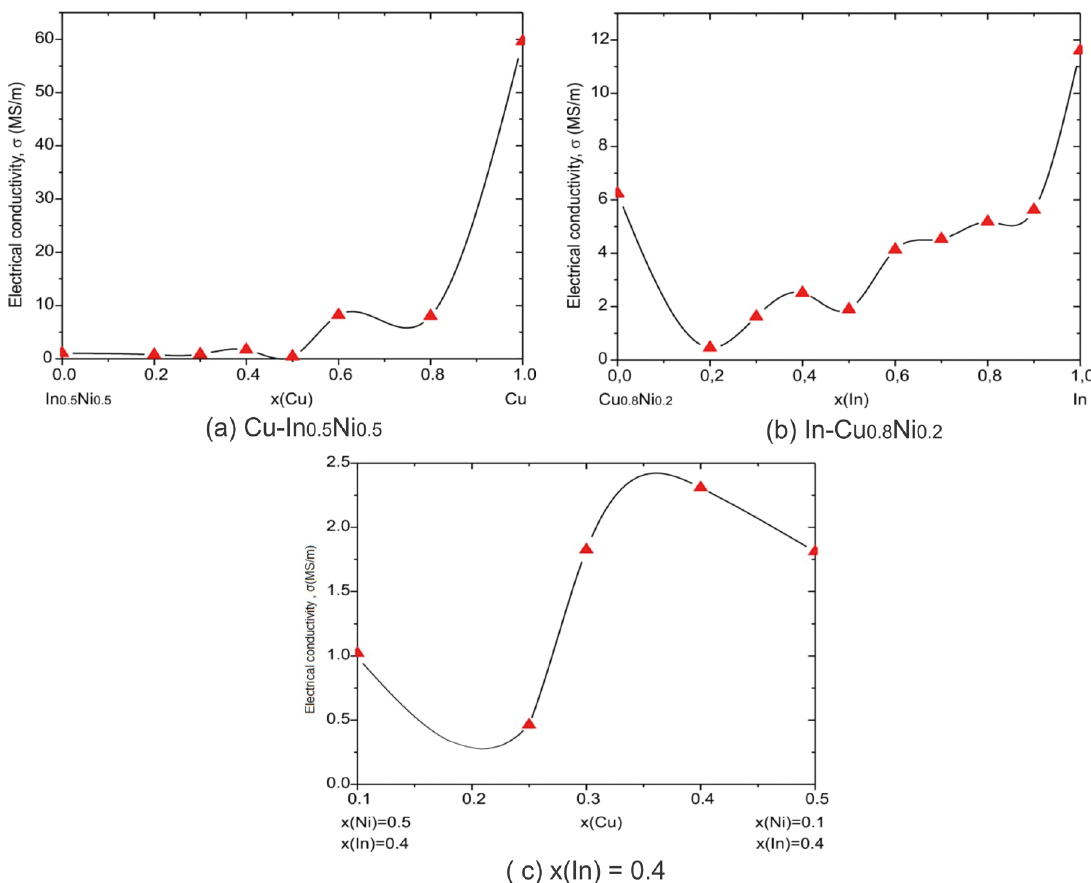
Ni , b) In- 0.5 0.5